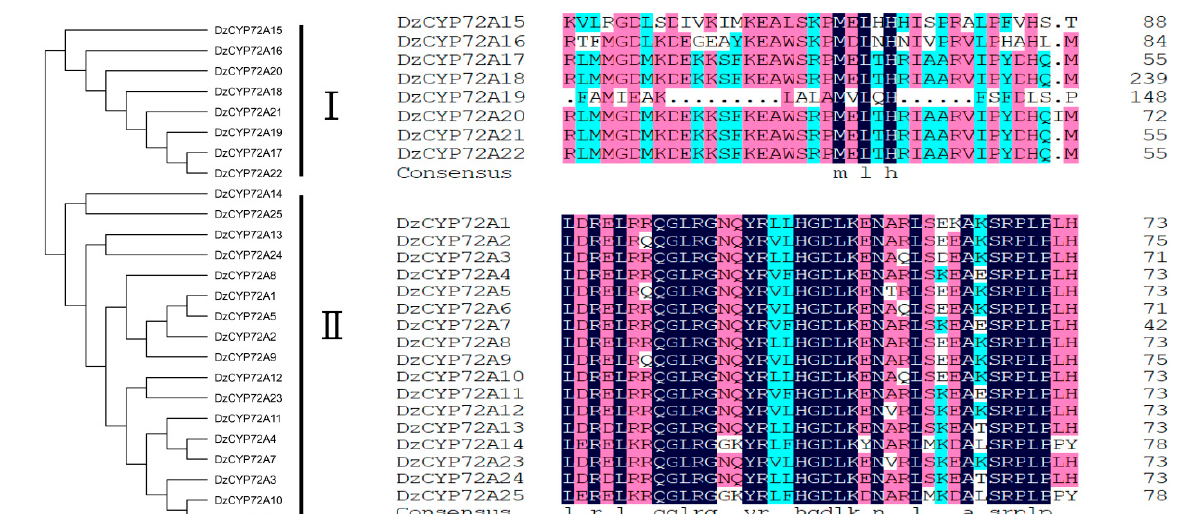
Figure 1. Phylogenetic tree of DzCYP72A proteins.